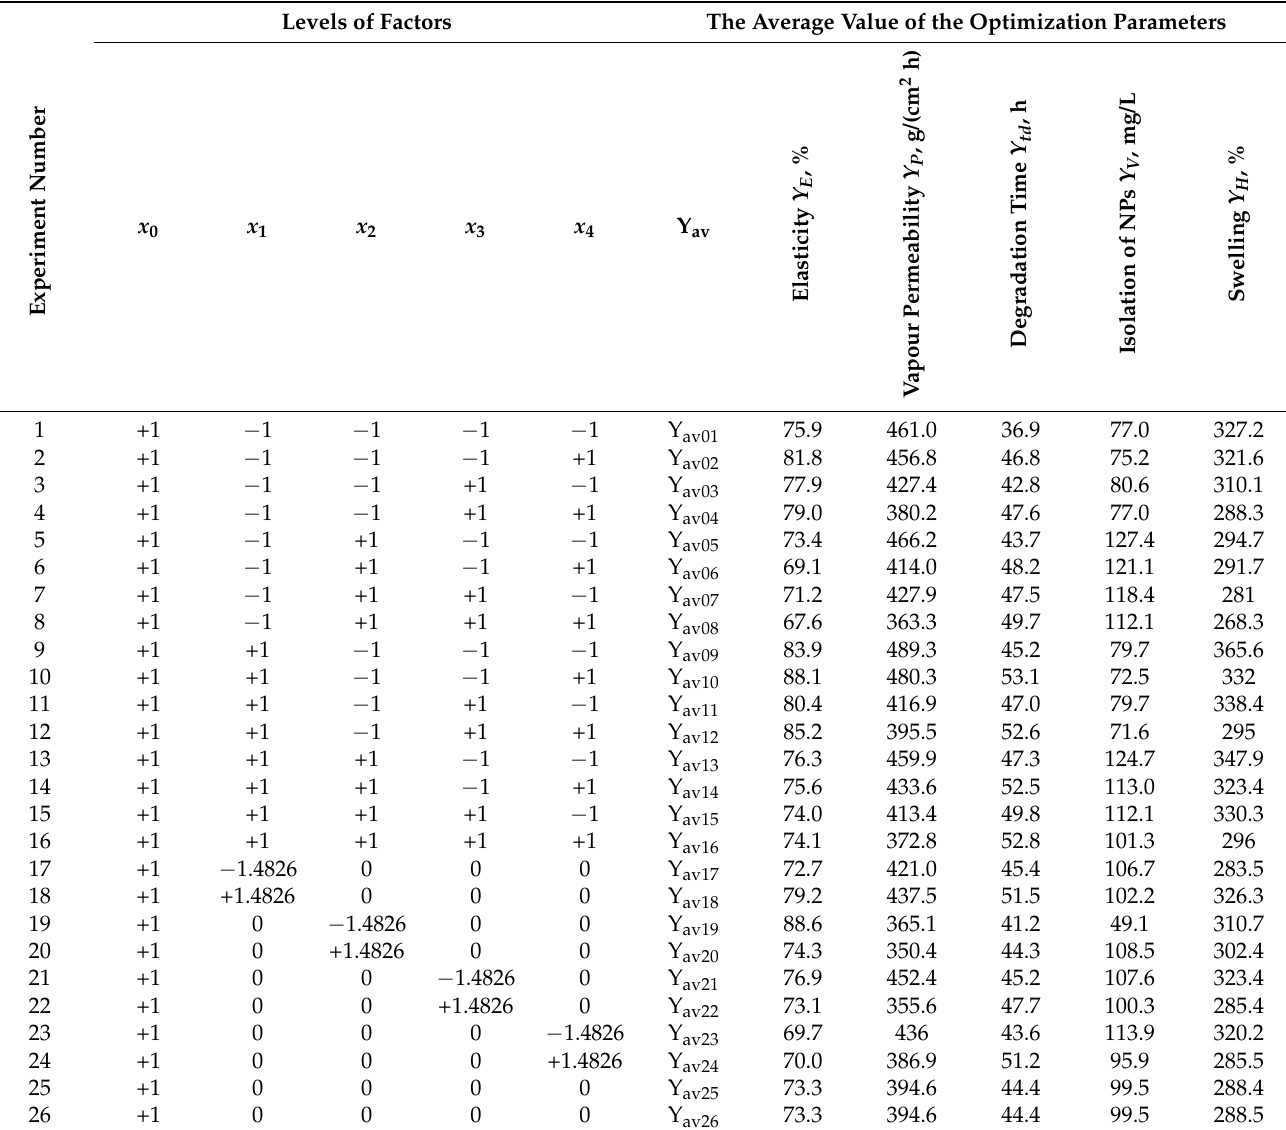
Table A1. Plan-matrix of experimental